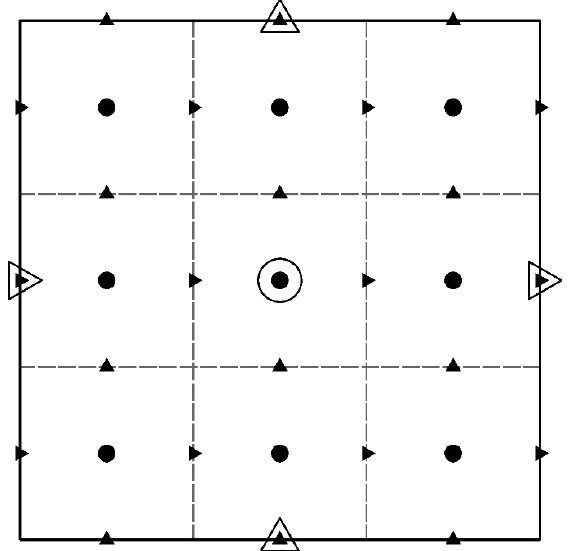
Figure 1. A coarse grid cell divided into nine fine grid cells with the refinement ratio of 3 in both horizontal directions and variable distributions on a C-grid. The coarse-resolution grid (CRG) variables and high-resolution grid (HRG) variables are represented by the hollow and solid symbols, respectively.